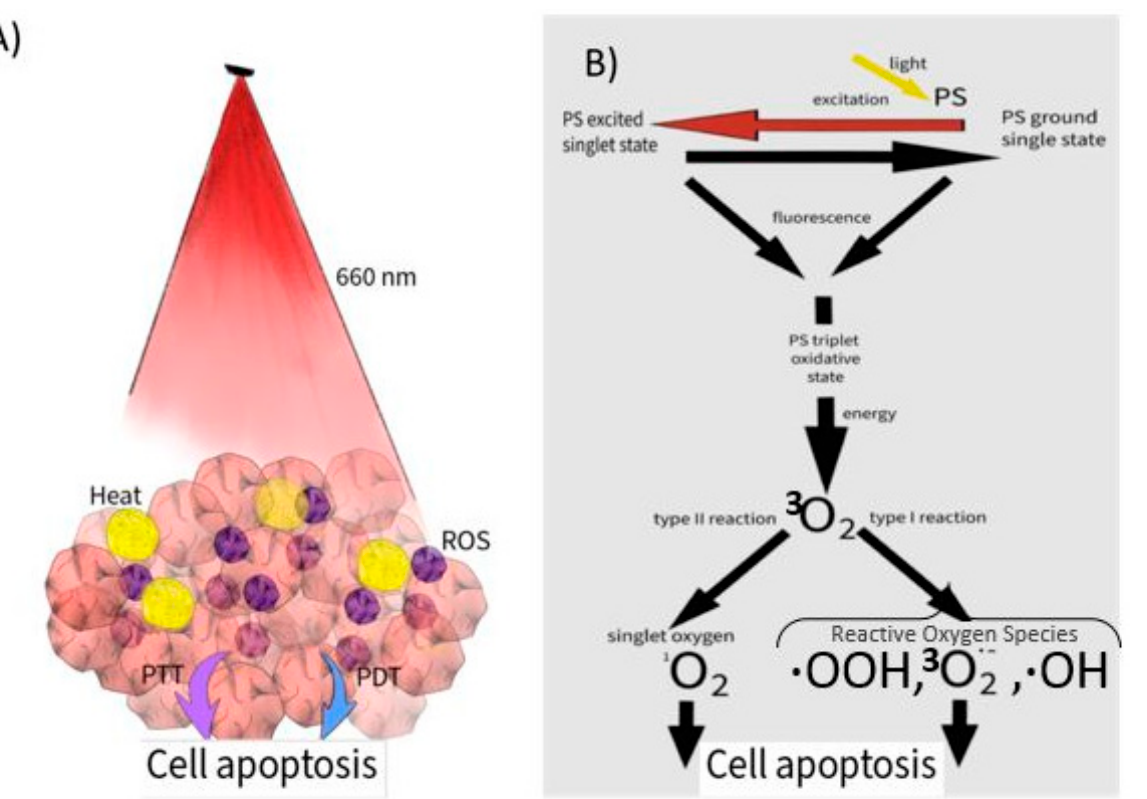
Figure 1. ( A ) Action of PDT in skin tissue. ( B ) The utilization of a photosensitizer (PS) in skin tissue. Clinically approved photosensitizers are used in PDT along with ground-state oxygen ( 3 O 2 ) and visible light to treat tumors by the local production of cytotoxic singlet oxygen ( 1 O 2 ). PDT is based